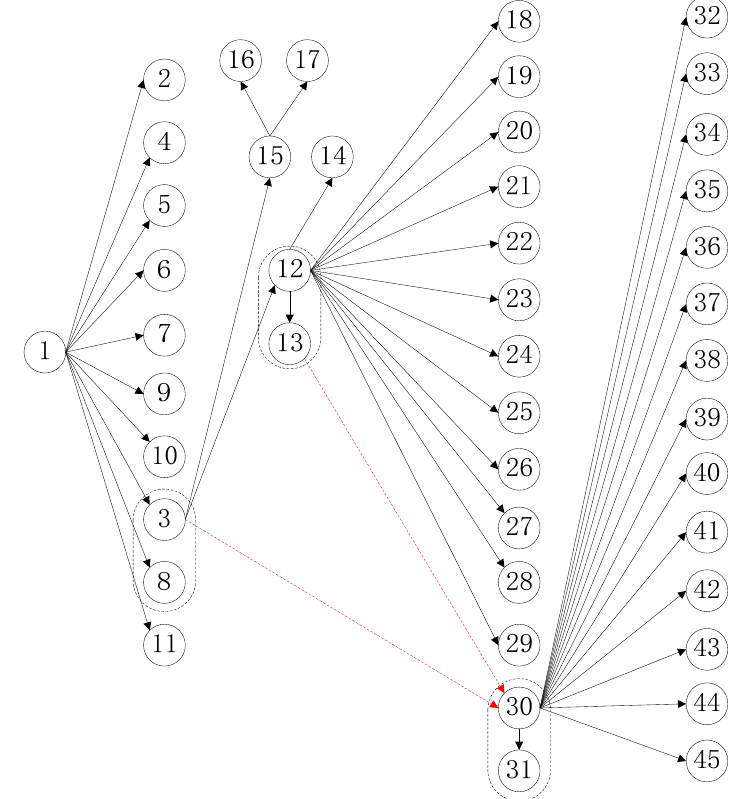
Figure 7. Processing constraint relationship 1.